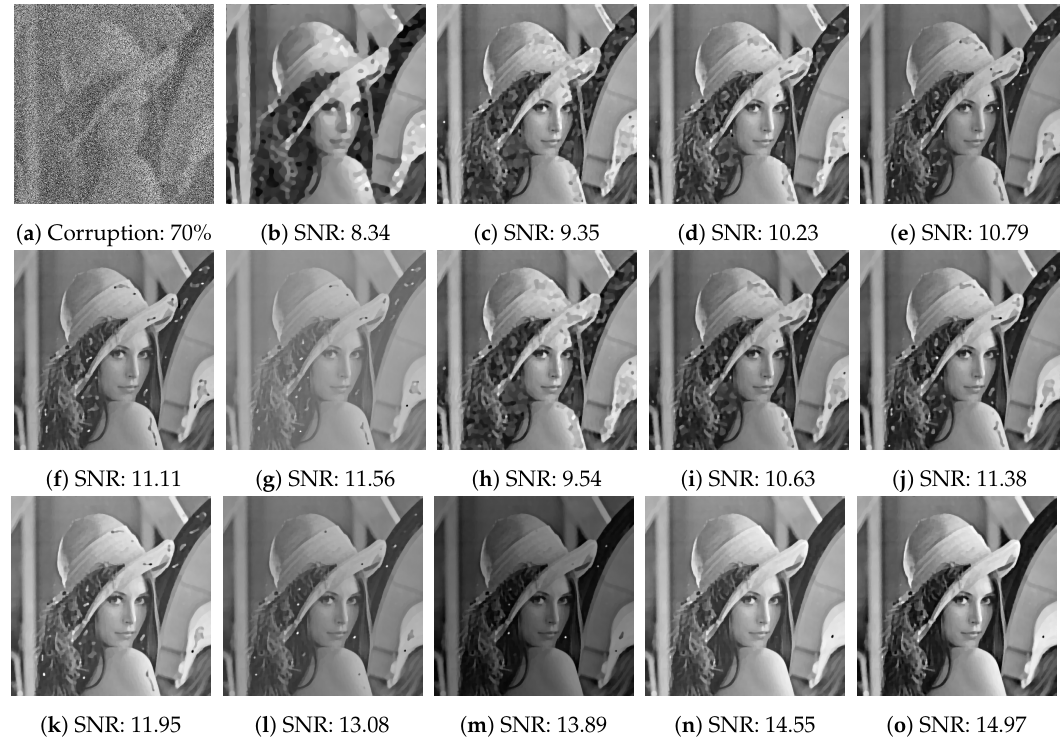
Figure 14. Restored images of TVL1, CTVL1 and HOCTVL1 model on the Lena image corrupted by Gaussian blur and random-valued noise with noise level 70%. ( a ) Corrupted image. ( b ) TVL1 model. ( c – g ) first correction step to fifth correction step of CTVL1 model. ( h – o ) first correction step to eighth correction step of HOCTVL1